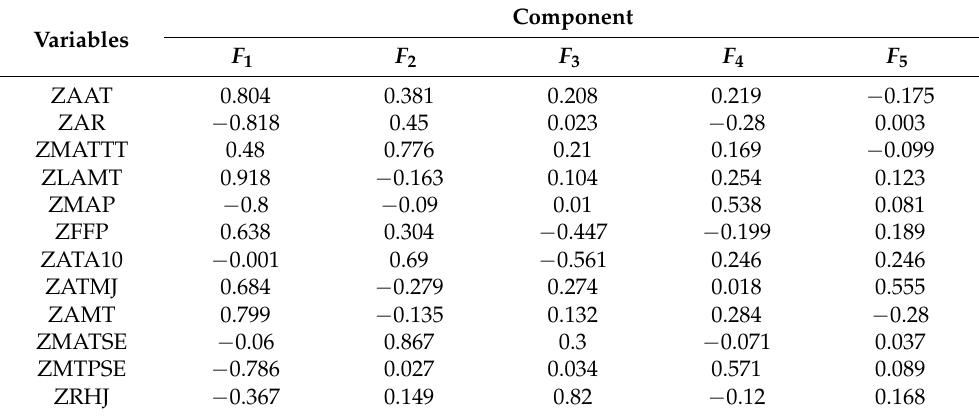
Table 5. Load matrix of different meteorological